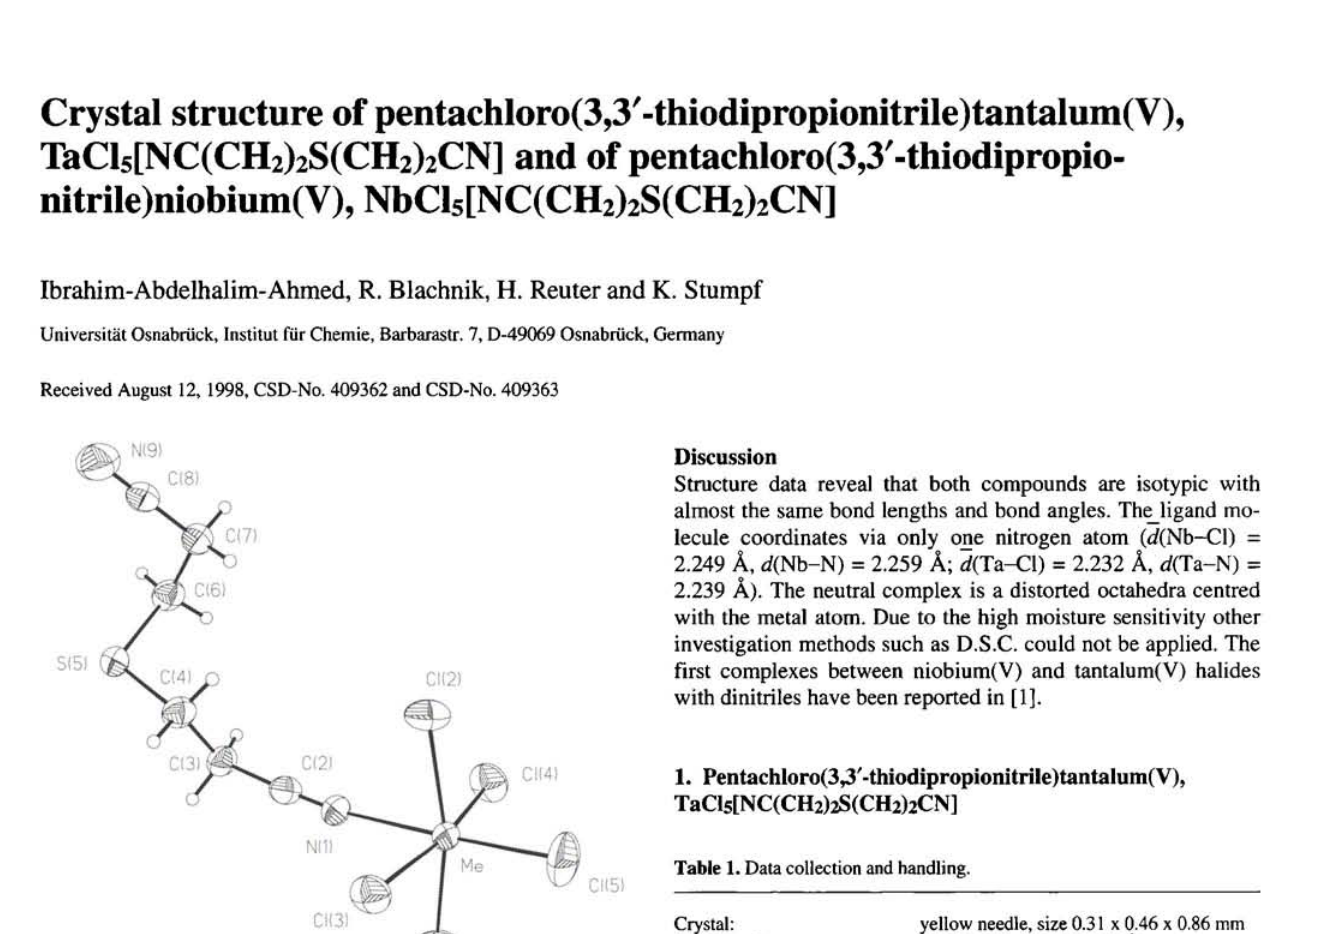
Table 2. Atomic coordinates and displacement parameters (in Â 2